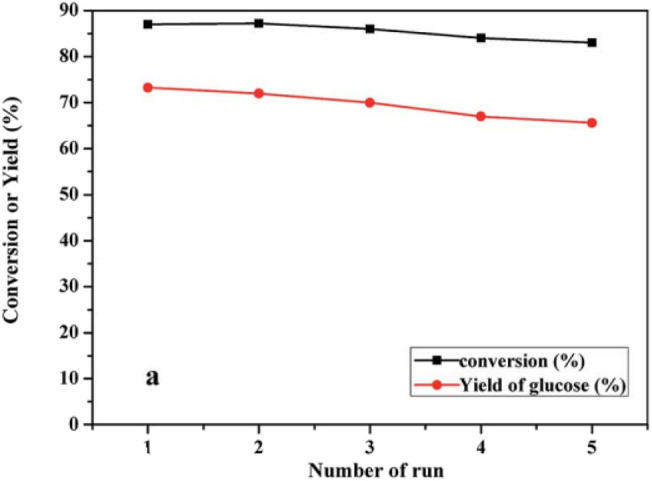
The circulation reaction test of the [C16H33N(CH3)3]H5P2W18O62 catalyst in conversion of cellulose to glucose. Reaction conditions: 100 mg cellulose, 0.08 mmol catalyst, 5 mL H2O, 160°C for 9 h. Reproduced with permission from Sun et al. (2015).